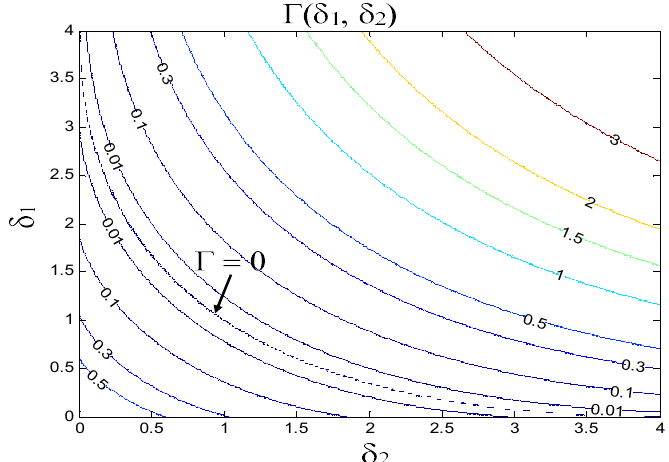
Figure 3. Function that presents regular and positive function.